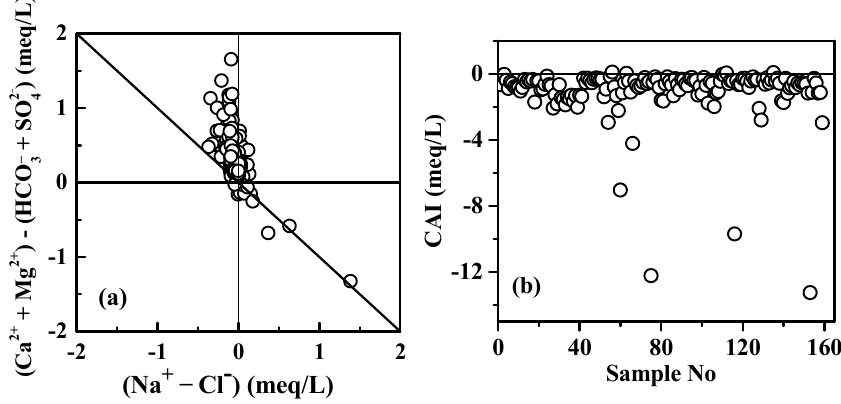
Figure 8. ( a ) Relationships between [(Ca 2+ + Mg 2+ ) − (SO 4 2 − + HCO 3 − )] and [(Na + − Cl − )] in groundwater sampels, ( b ) Chloro ‐ Alkaline indices (CAI) of groundwater samples.